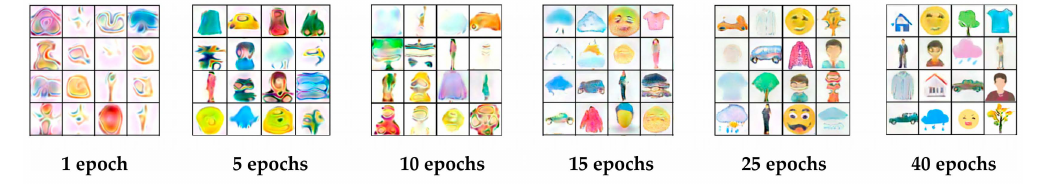
Figure 6. Visualization of the generation process.